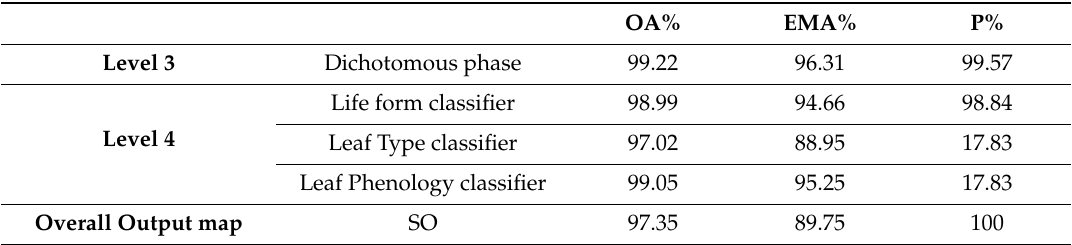
Table 8. OA and entropy-modulated accuracy (EMA) values for each SO hierarchical classification phase. P is the percentage of the reference data used in each specific confusion matrix